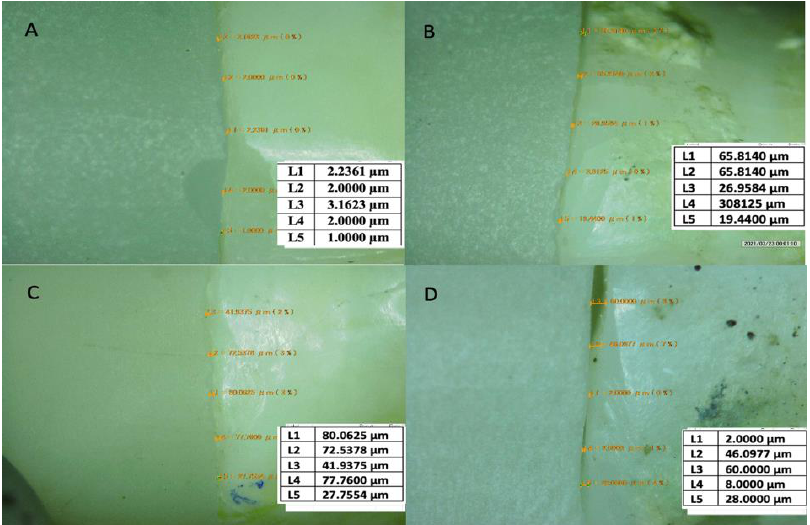
Figure 6. Marginal gap measuring using a digital microscope. ( A ) Celtra Duo without intraradicular